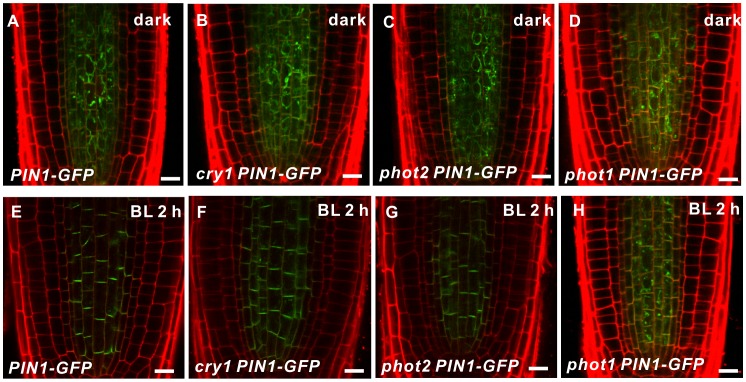
Blue-light-induced PIN1 is regulated by phot1 during root negative phototropism.(A–H) PIN1 localization, as revealed by GFP fluorescence, in the stele of PIN1::PIN1-GFP (A, E), PIN1::PIN1-GFP cry1 (B, F), PIN1::PIN1-GFP phot2 (C, G), and PIN1::PIN1-GFP phot1 (D, H) seedlings grown in darkness (A–D) or under blue light (E–H) (10 µmol m−2sec−1) for 2 h. At least twelve seedlings were imaged per line for each of three replicates. Bars = 10 µm.